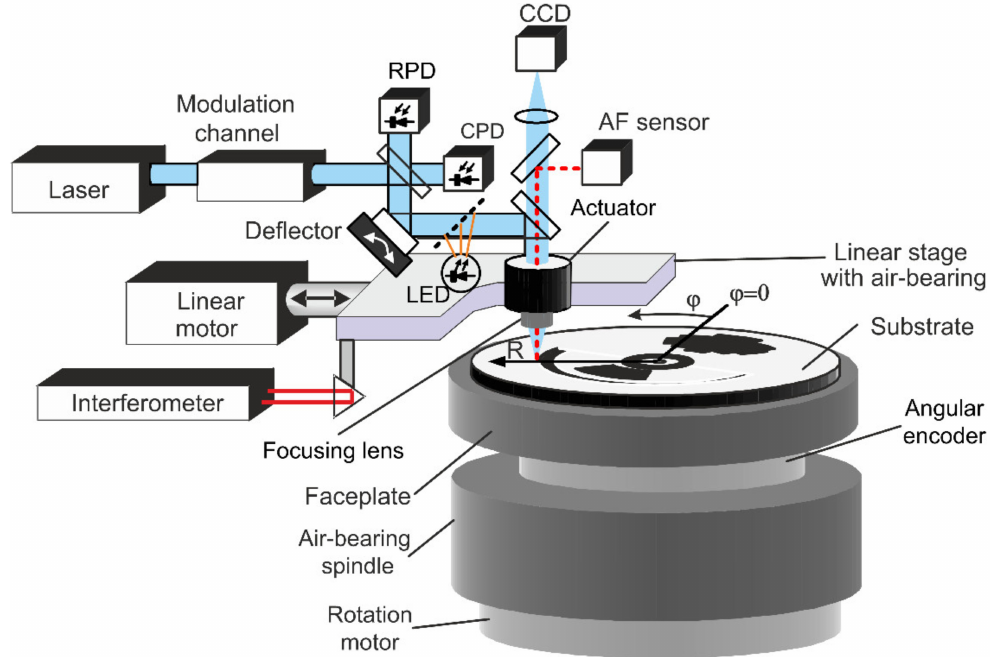
Figure 2. Simplified diagram of the CLWS (RPD—reflection photodetector, CPD –photodetector for laser beam power calibration, LED—LED illuminator for observing the surface with